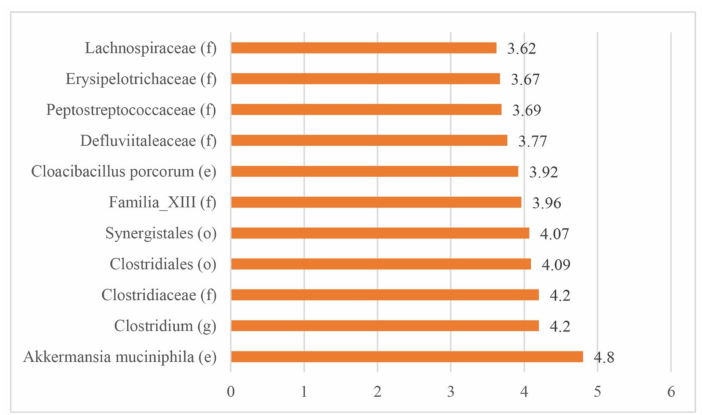
Figure 5. Biomarkers identified using the linear discriminant analysis e ff ect size (LEfSe) test in rabbits with ERE. (f): family, (e): species, (o): order, (g): genus.